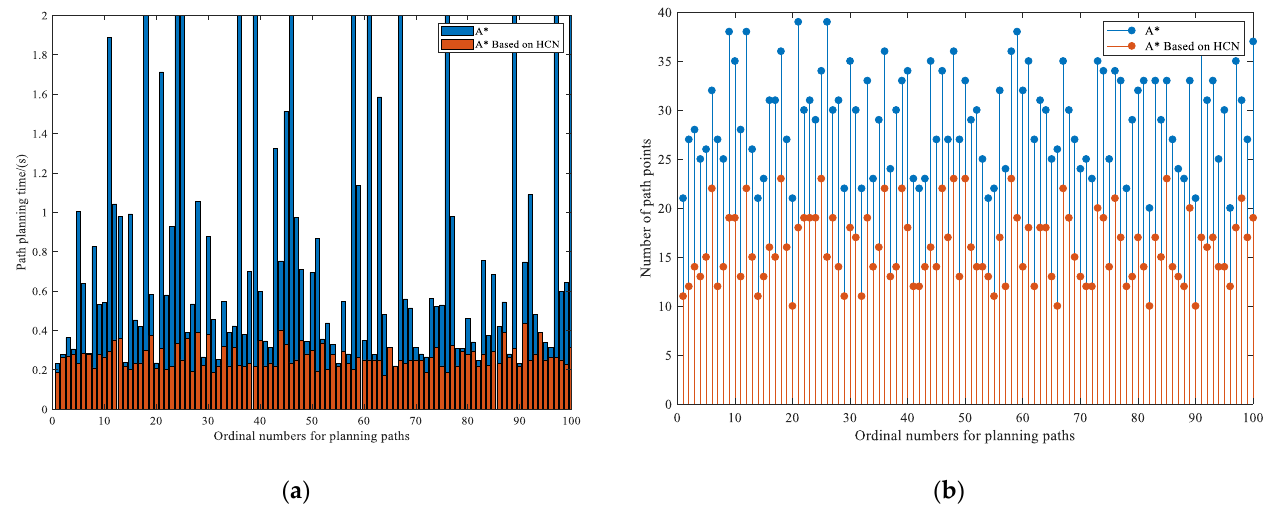
Figure 11. Comparison of collision-free path planning of manipulators using different maps. ( a ) Planning time; ( b ) path points.